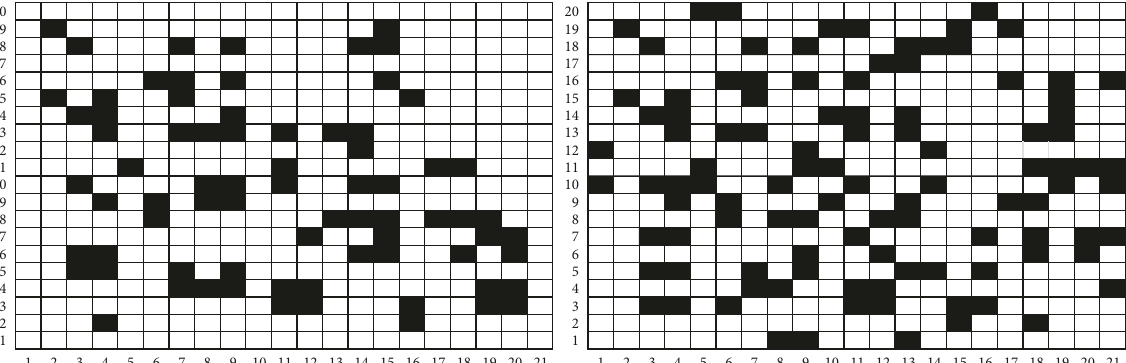
Figure 2: Path planning diagram.